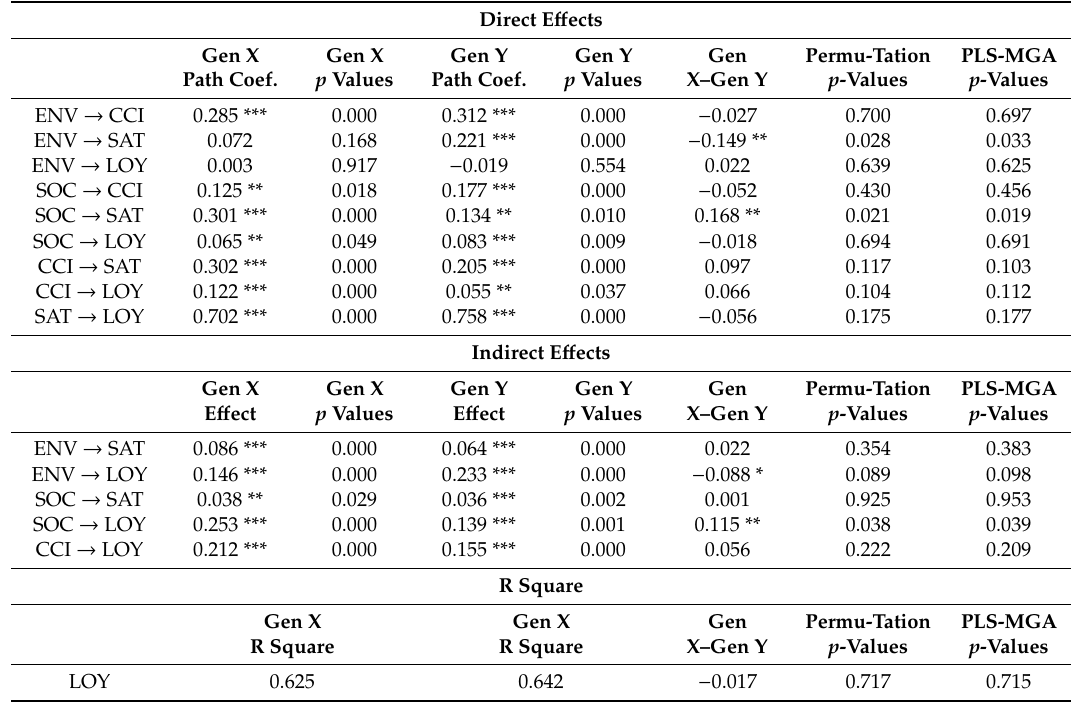
Table 7. Generation X vs. Generation Y multigroup